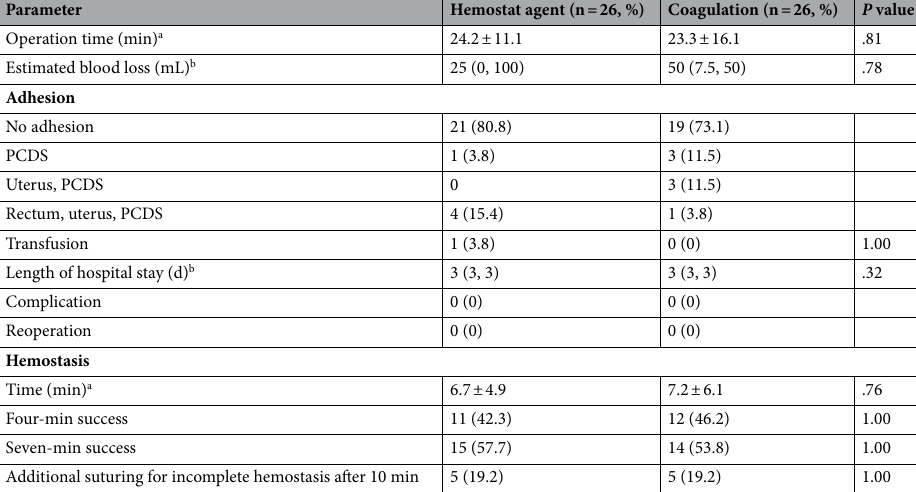
Table 2. Operative outcomes. PCDS posterior cul de sac. a Data were shown as mean ± standard deviation. b Data were shown as median with range.